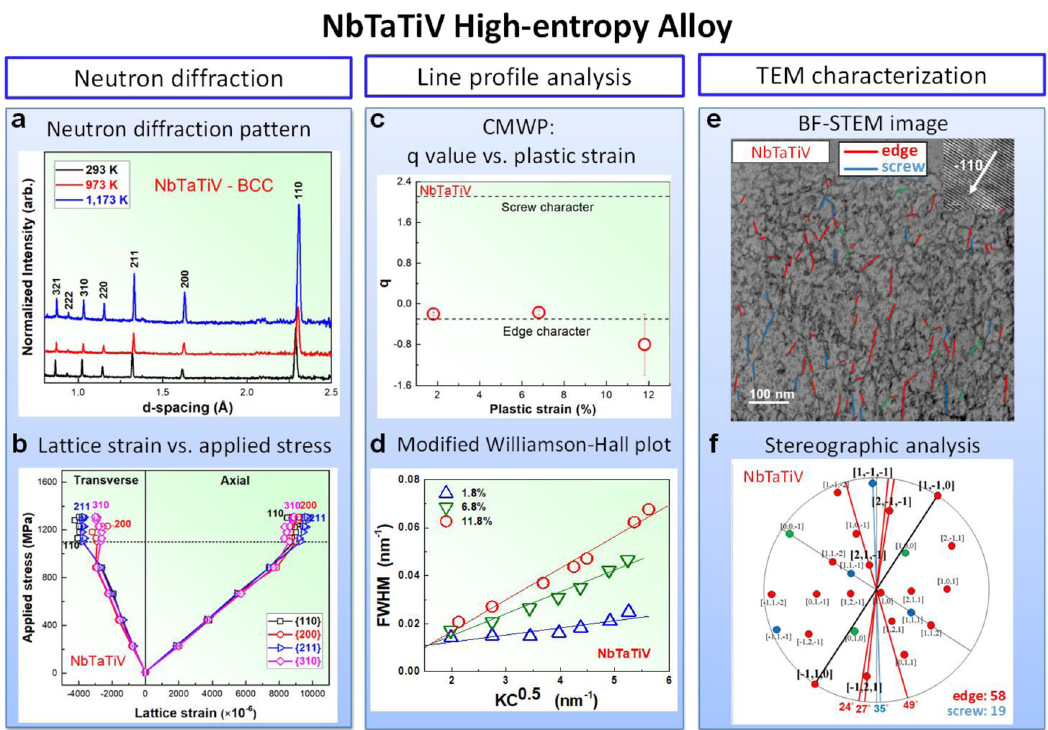
Fig. 2 Neutron diffraction and TEM experiments showing the dominance of edge dislocations in NbTaTiV. a Neutron-diffraction patterns presenting interplanar spacings with peaks indexed for the BCC structure of NbTaTiV, at temperatures of 293, 973, and 1173 K. b Axial and transverse lattice strains versus applied load, shown as the applied stress versus lattice strain so that the slopes correspond to the planar Young ’ s moduli ð E hkl Þ and Young ’ s moduli/ = ν Poisson ’ s ratios ð E Þ , as indicated for the {110}, {200}, {211}, and {310} planes, respectively, at T = 293 K. The onset of plastic yielding (yield stress) hkl hkl is presented as the dashed line. c Evolution of q parameters as a function of plastic strain, which is obtained from the Convolutional Multiple Whole Pro fi le (CMWP) fi tting. Dashed lines indicate values of q parameters for edge and screw character dislocations, considering a 15 % error margin for the elastic constants. The error bars in the q-parameter values are determined by the fractions of edge or screw dislocations. d Modi fi ed-Williamson-Hall plot, FWHM versus KC 0 : 5 at plastic strains of 1.8 %, 6.8 %, and 11.8 %, respectively, at T = 293 K. The plots were obtained from the physical pro fi les calculated by the CMWP procedure, considering free of the instrumental effects on the FWHM data. The pattern of the undeformed specimen was applied to the CMWP procedure as an instrumental pattern. The much better agreement of the data with the edge analysis demonstrates th e dominance of edge dislocations. e Annular-Bright- fi eld (ABF)-STEM image of NbTaTiV at a plastic strain of 11.8% with a two-beam condition near Z ¼ ½ 110 (cid:3) and g ! ¼ ð (cid:1) 110 Þ . All straight dislocation lines longer than 5 nm are highlighted by blue and red lines, corresponding to their identi fi cation as edge and screw dislocations, respectively. f Stereographic projection related to the [110] orientation, where [ (cid:1) 110] has been aligned with images in ( e ). All possible dislocations are indicated, and those corresponding to the images in ( e ) are highlighted in bold. The degrees indicate the angles with respect to the [ (cid:1) 110] direction. Blue lines/blue symbols present those dislocations identi fi ed as edge, and red lines/symbols indicate those dislocations identi fi ed as screw. The green lines/symbols represented the dislocations that could be either edge or screw, which was excluded in the ratio calculation. As a result, ~75% of the dislocations are identi fi ed as